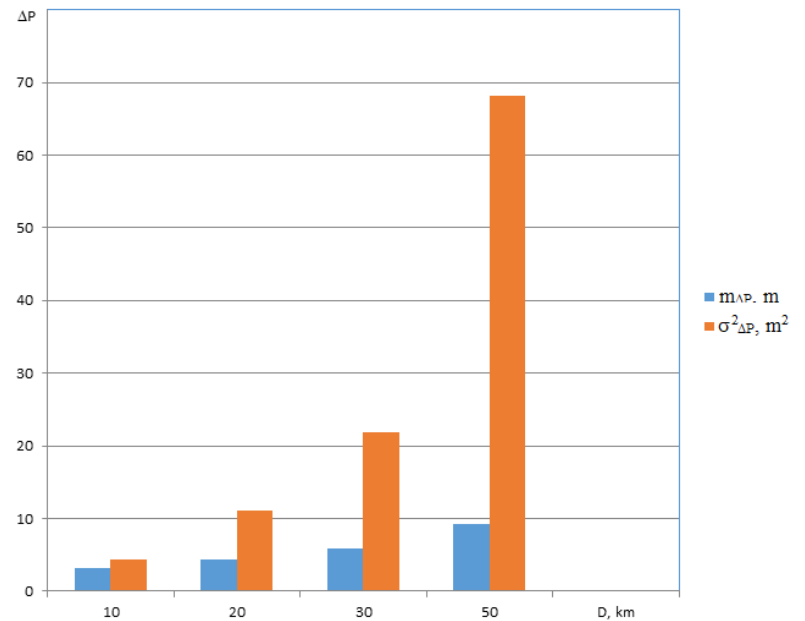
Figure 10. Accuracy of ACS positioning for selected positions FOs, straight flight.